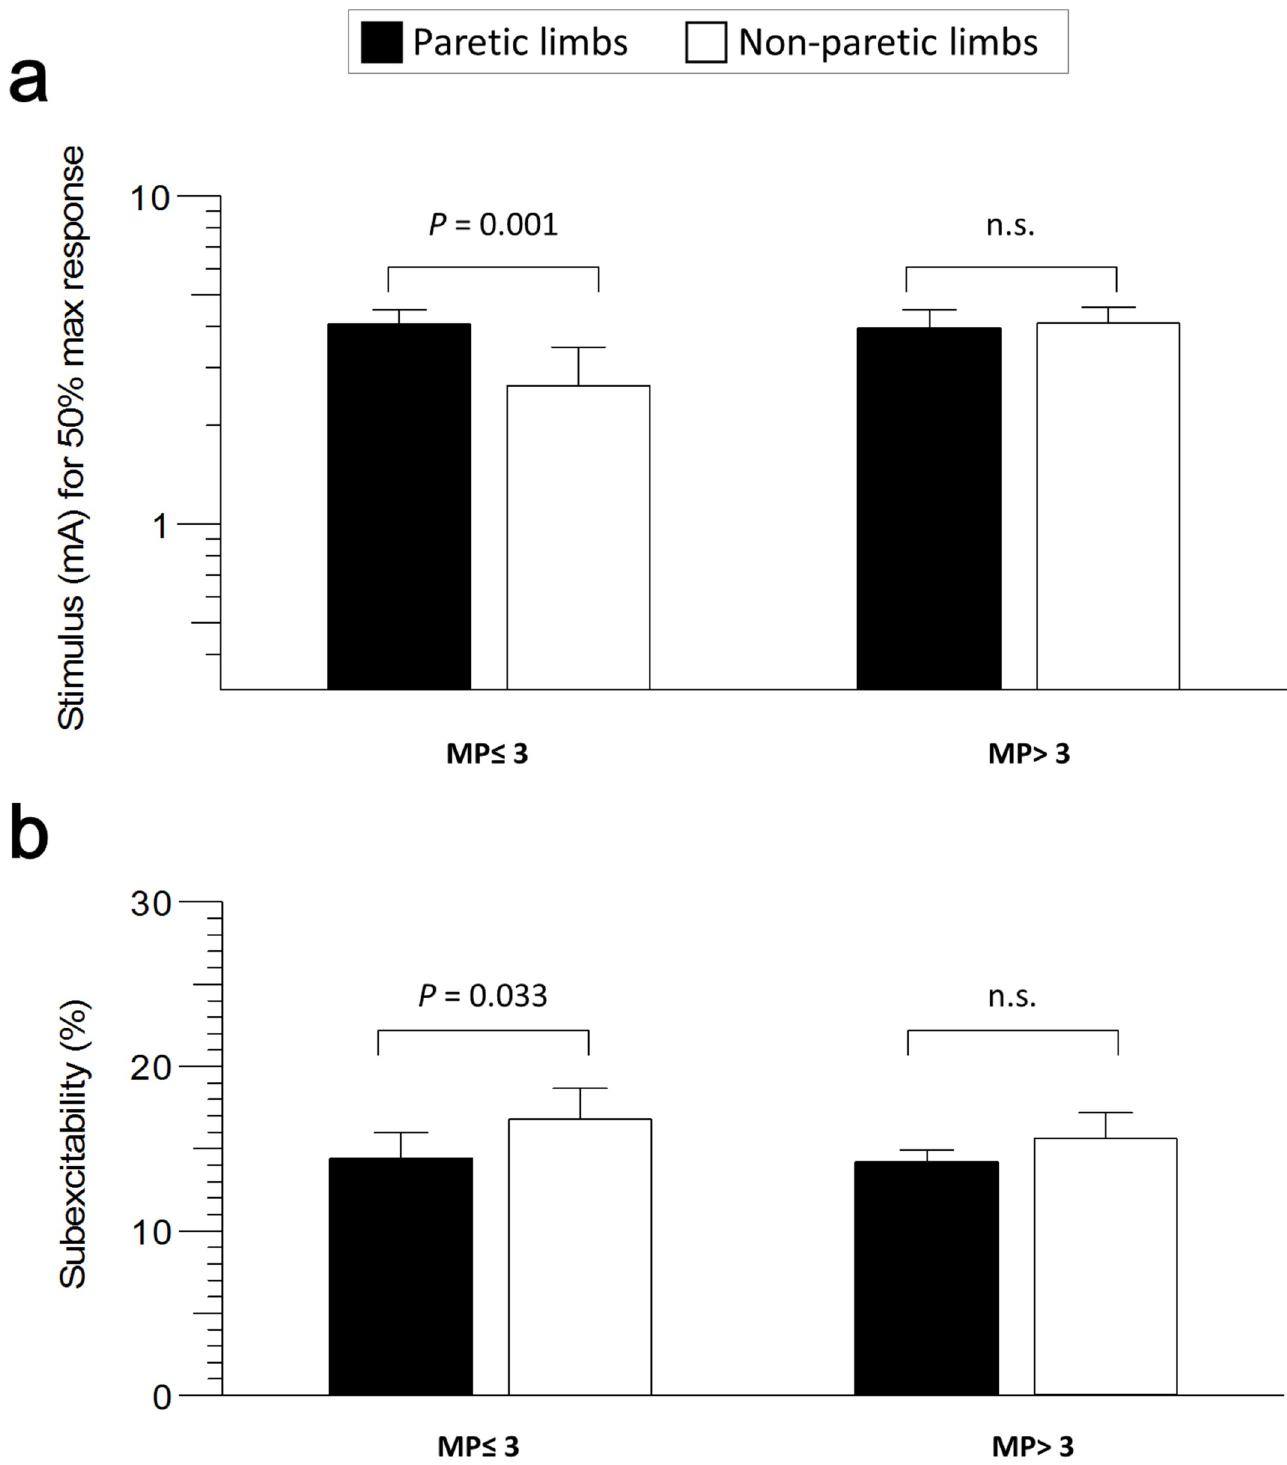
Fig 2. Comparison of the different nerve excitability changes between paretic limbs (black bars) and non-paretic limbs (white bars) in the patients with severe (MP � 3) and mild (MP > 3) weakness. a. Increased stimulus current needs to achieve 50% maximal response of paretic limbs in the MP � 3, but no change in the MP > 3 cohort. b. Decreased subexcitability of paretic limbs only showed significantly in the MP � 3 cohort.